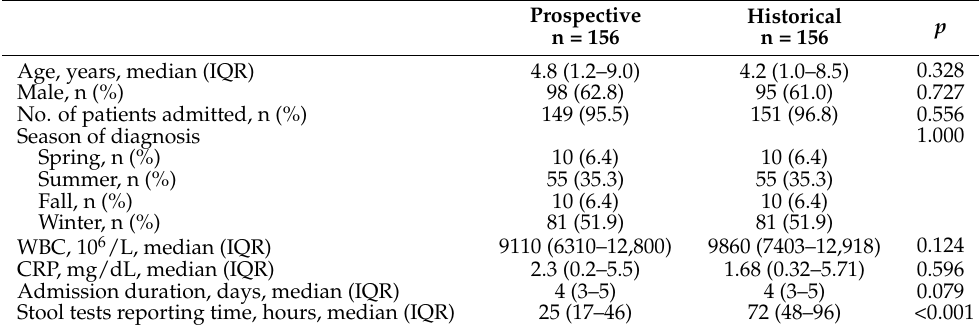
Table 2. Comparison of clinical parameters between the prospective and historical